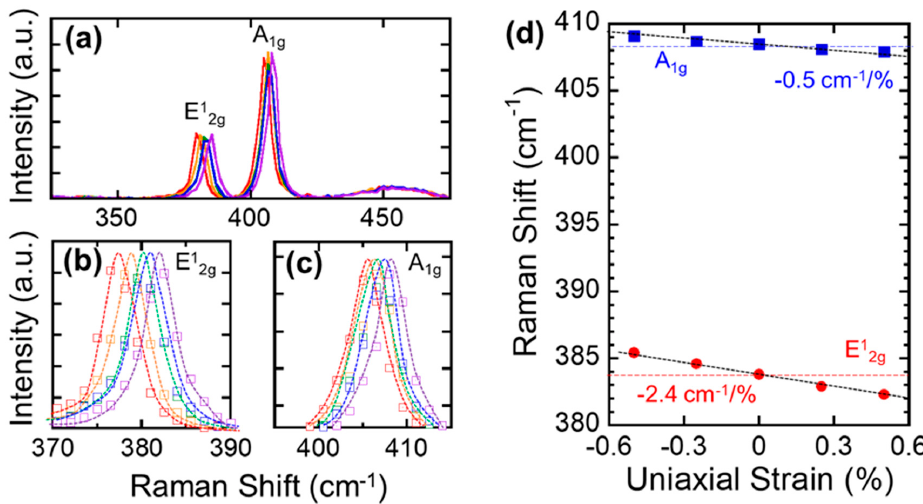
Figure 5. ( a ) Raman spectra of MoS 2 crystal measured under the uniaxial strains and magnified Raman spectra of ( b ) E 12g mode and ( c ) A 1g mode. Rainbow color lines represent different types and intensities of strains; (red) 0.5% compressive strain, (orange) 0.25% compressive strain, (green) flat, (blue) 0.25% tensile strain, (purple) 0.5% tensile strain. ( d ) E 12g mode and A1g mode as a function of applied strain.